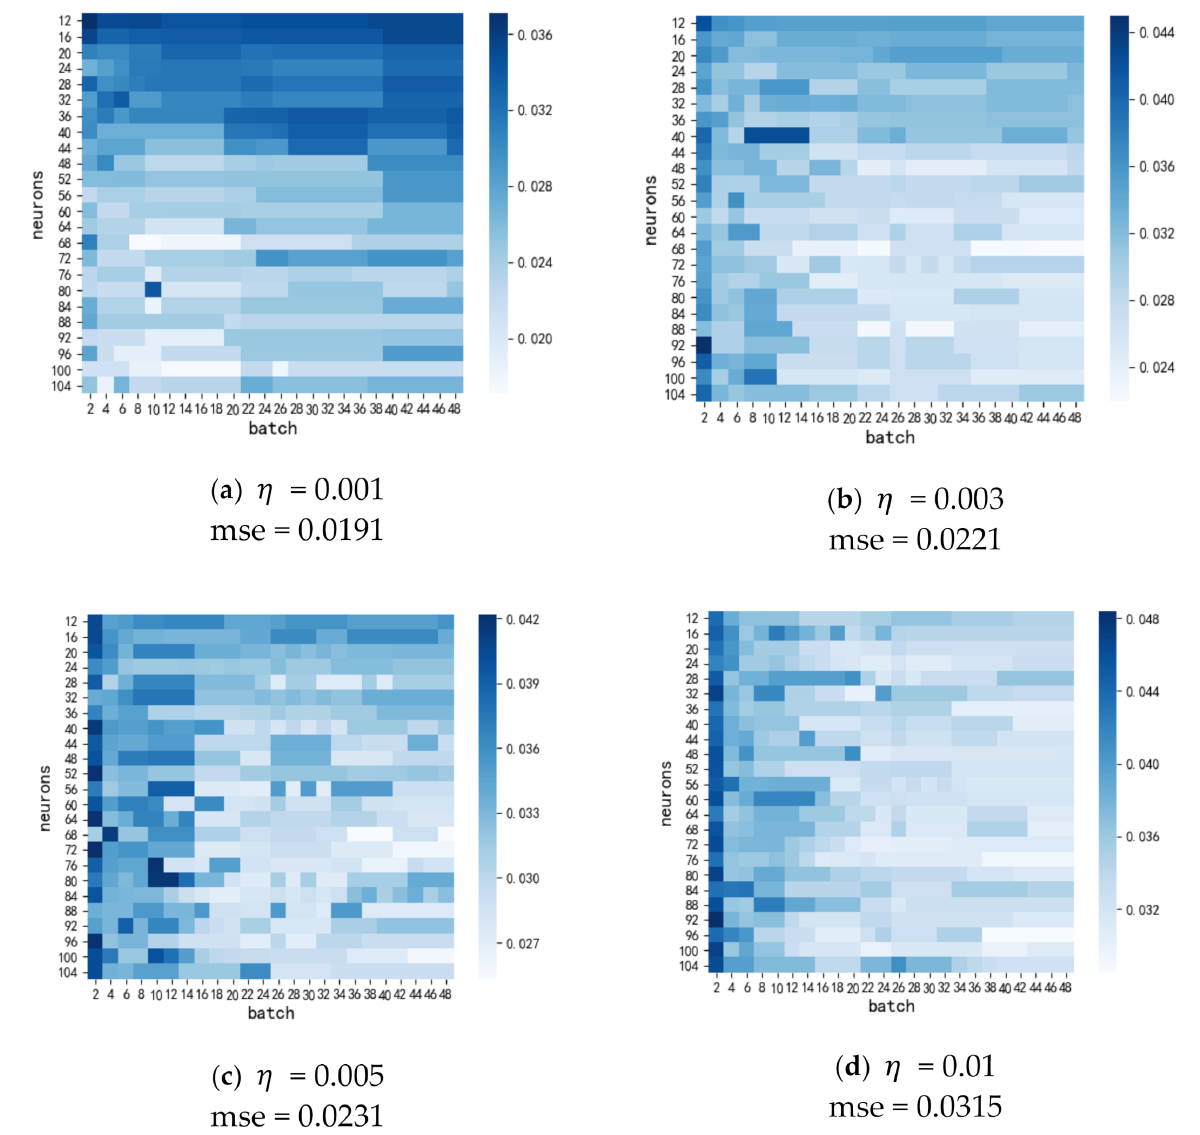
Figure 6. Results of grid search with three parameters.